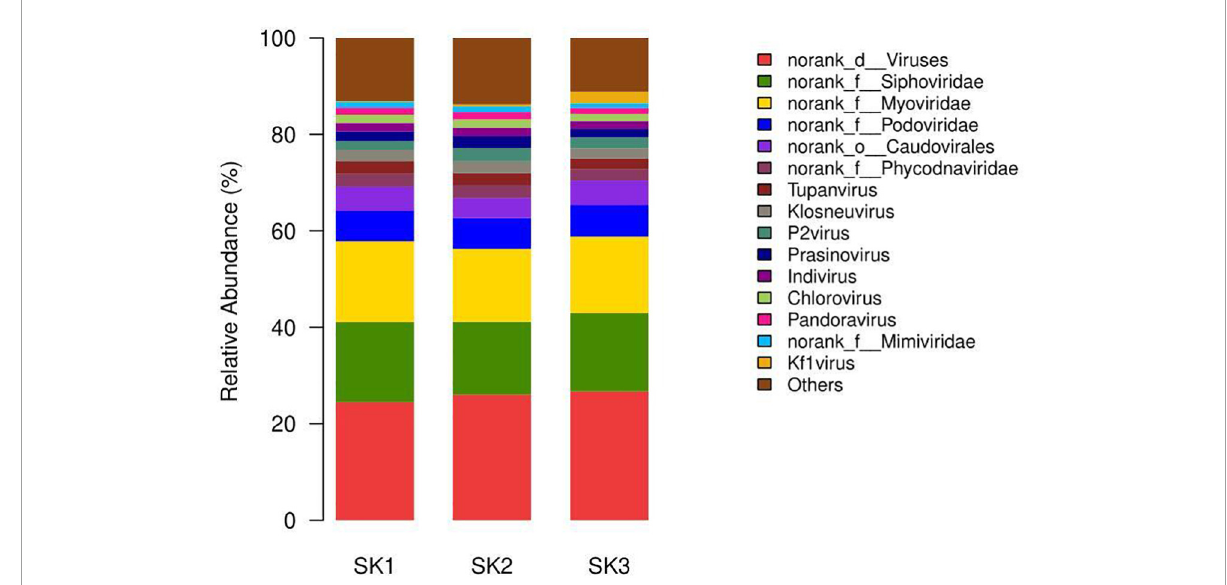
FIGURE4 The microbial community bar plot of virus genus of the three Melophagus ovinus